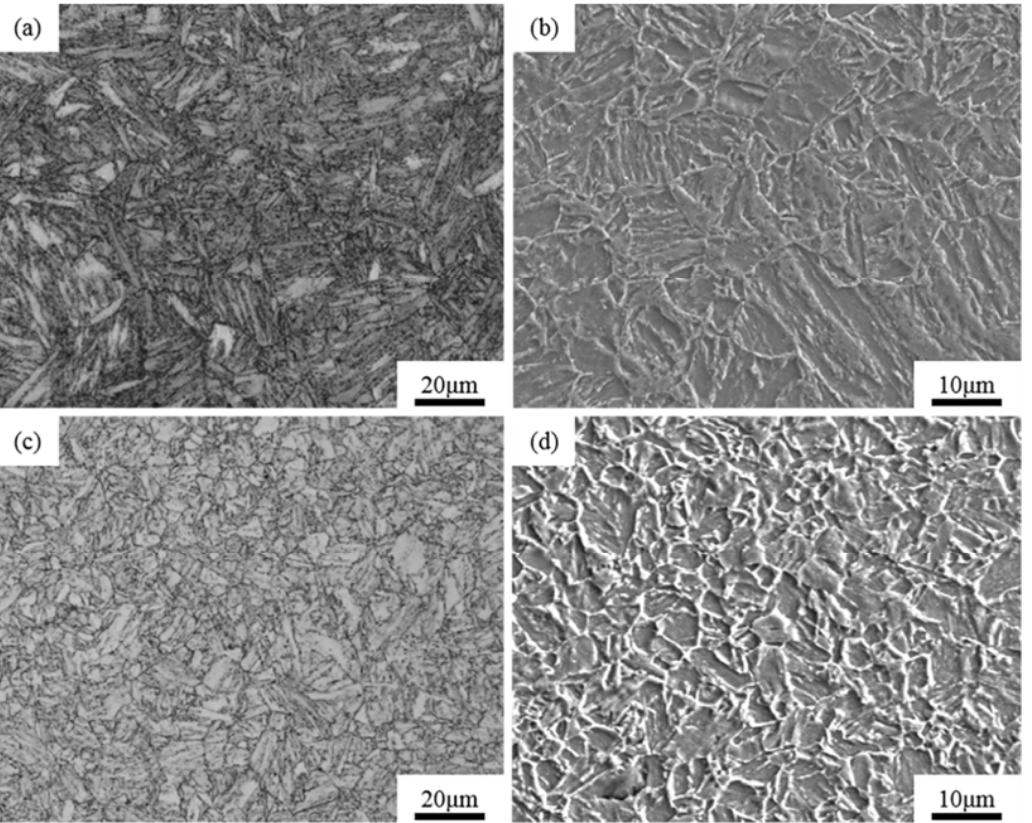
Figure 5. Microstructure images of OM and SEM in the same conditions; ( a ) OM micrographs in Al-Steel; ( b ) SEM micrographs in Al-Steel; ( c ) OM micrographs in Zr-Steel; ( d ) SEM micrographs in Zr-Steel.